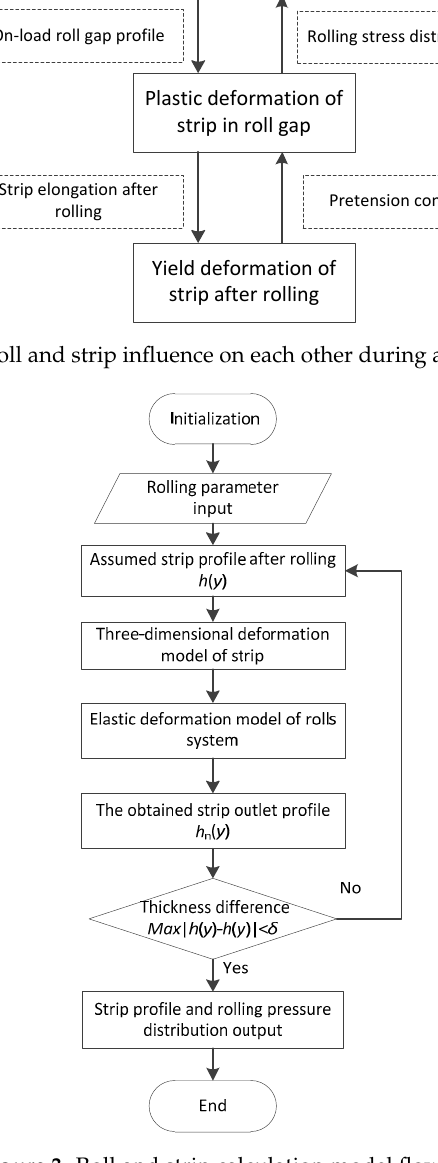
Figure 3. Roll and strip calculation model flow chart.